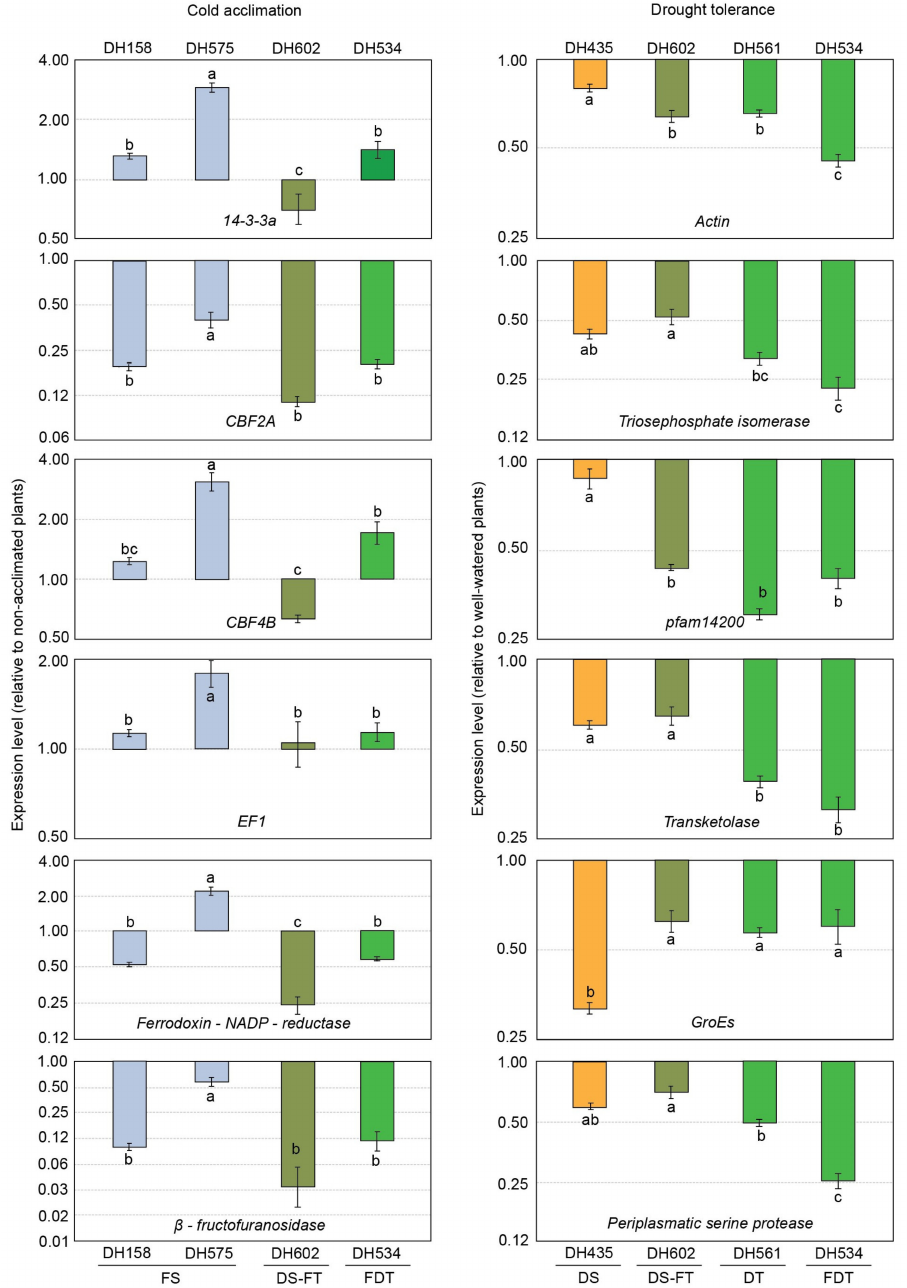
Figure 1. The expression of selected genes during cold acclimation or drought treatment relative to untreated plants in six double haploid lines of winter barley. FS, freezing-susceptible; DS–FT, drought-susceptible–freezing-tolerant; FDT, freezing- and drought-tolerant; DS, drought-susceptible; DT, drought-tolerant. Error bars represent standard error between means of three biological replicates, each with three instrumental repetitions. Analysis of variance was made separately for each gene. Values marked with the same letter do not di ff er according to Tukey’s test ( p ≤